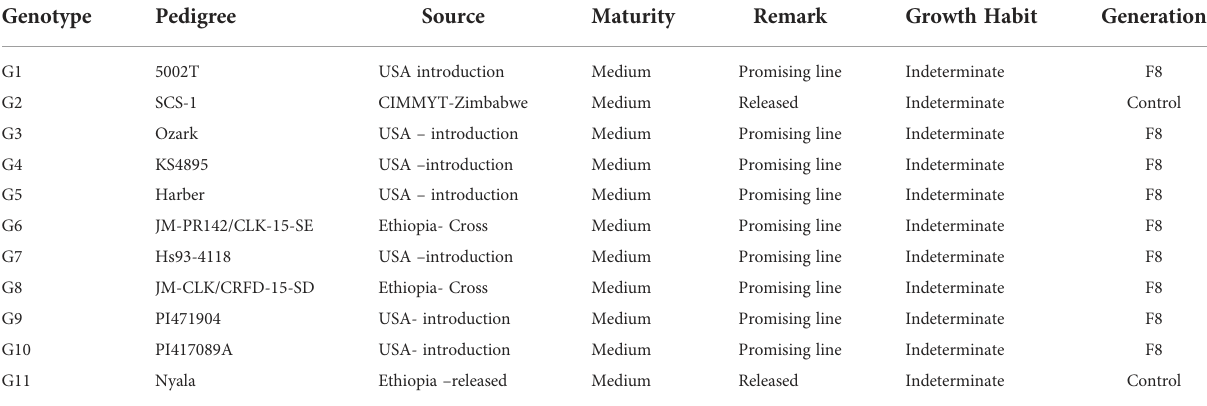
TABLE 1 Description of the eleven soybean genotypes used in this